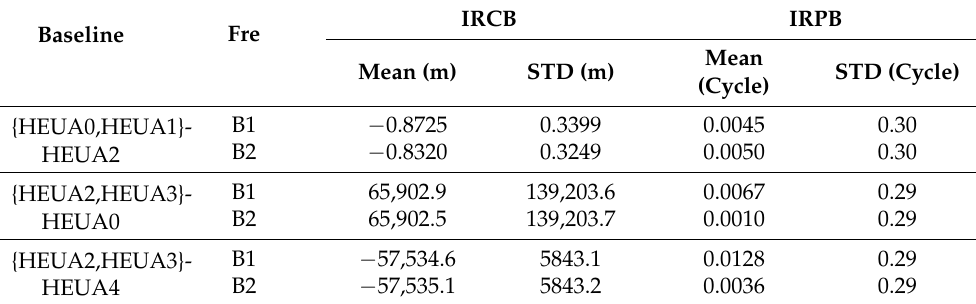
Figure 5. The estimation results for IRCB and IRPB under non-common clock mode. The receiver types are all UB380. The panels from top to bottom represent IRCB and IRPB at B1 and B2 frequency, and the blue-green dotted line is the corresponding mean of IRB. Table 3. IRB statistics results under non-common clock mode.